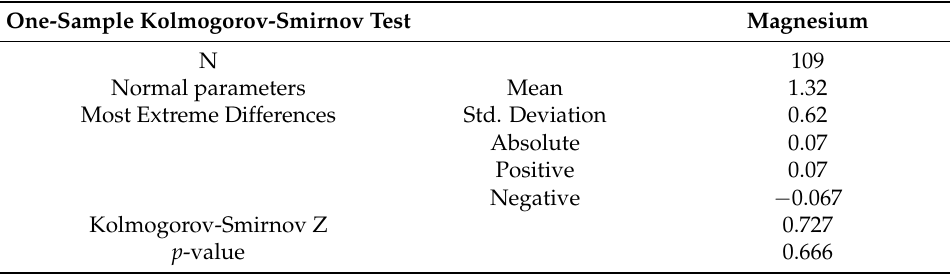
Table 4. Not normal data tabulation before normality